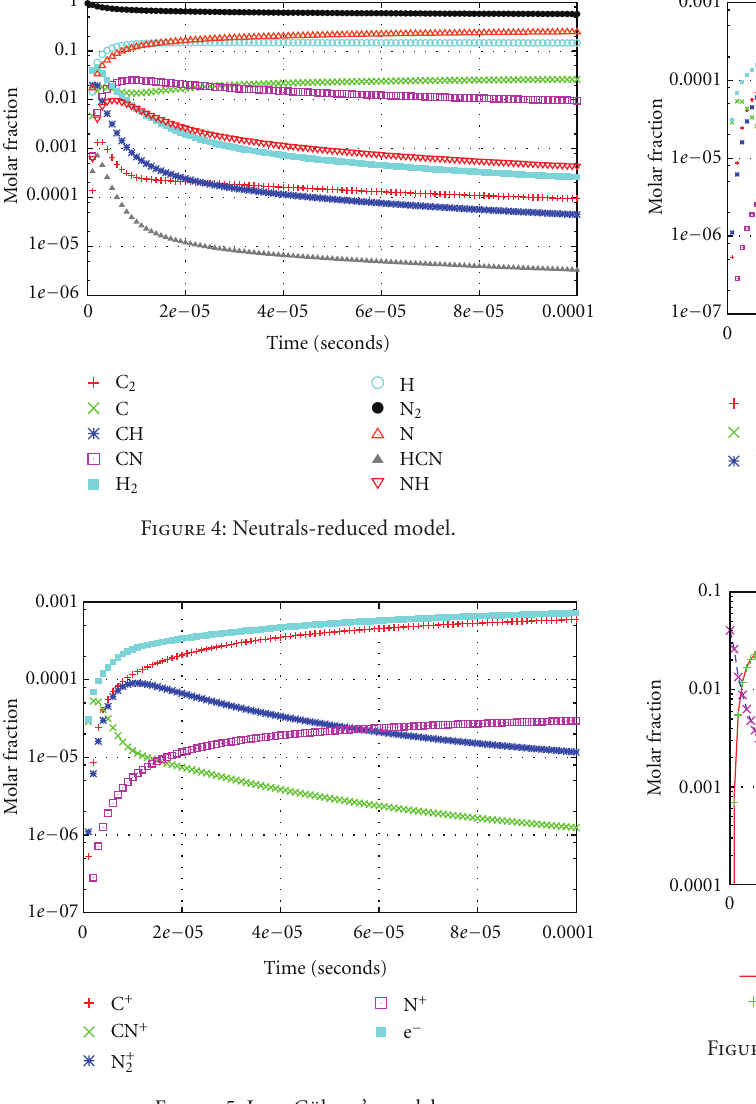
Figure 5: Ions-G¨okc¸en’s model.